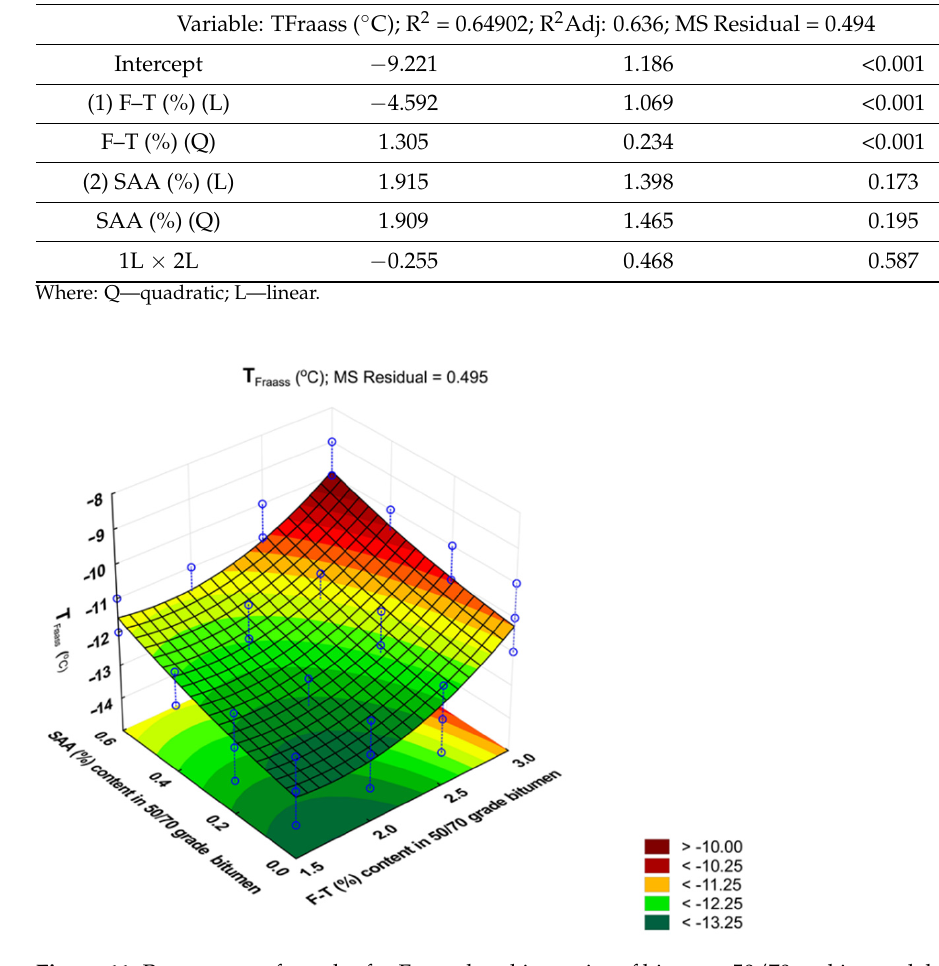
Figure 11. Response surface plot for Fraass breaking point of bitumen 50/70 and its model.